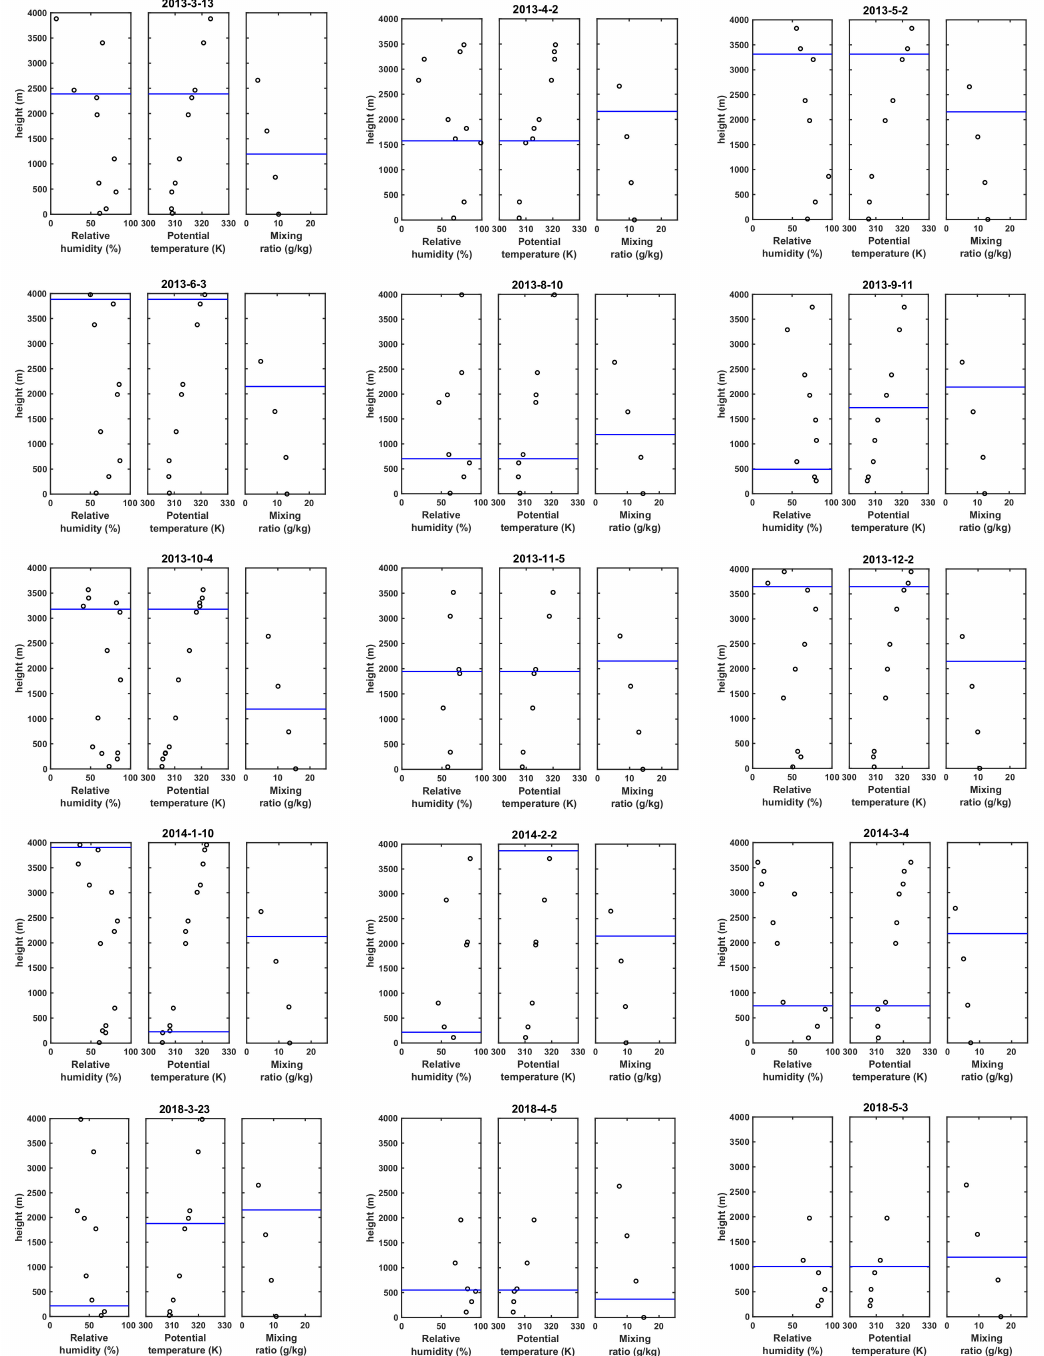
Figure 2. Relative humidity (from radiosondes), potential temperature (from radiosondes), and mixing ratio profiles (from MODIS) for twelve dates at Entebbe airport. The horizontal blue lines show the ABLH determined from gradients of these